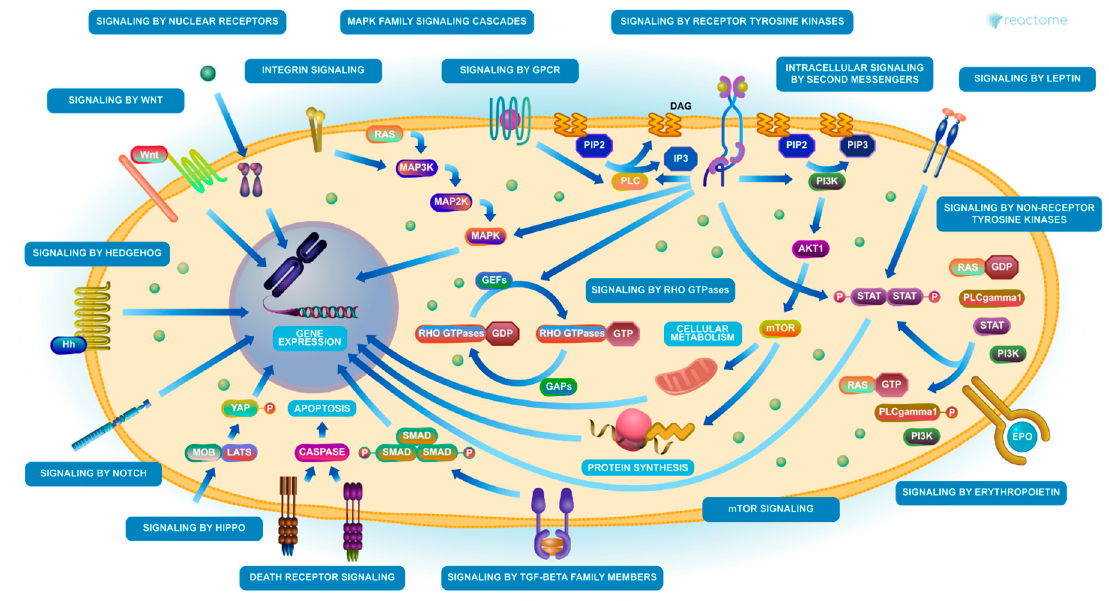
Figure 2. Overall signaling cascades, including the TGF-beta SMAD cascade (reproduced with permission of Reactome Pathway, Fabregat et al. [184]).